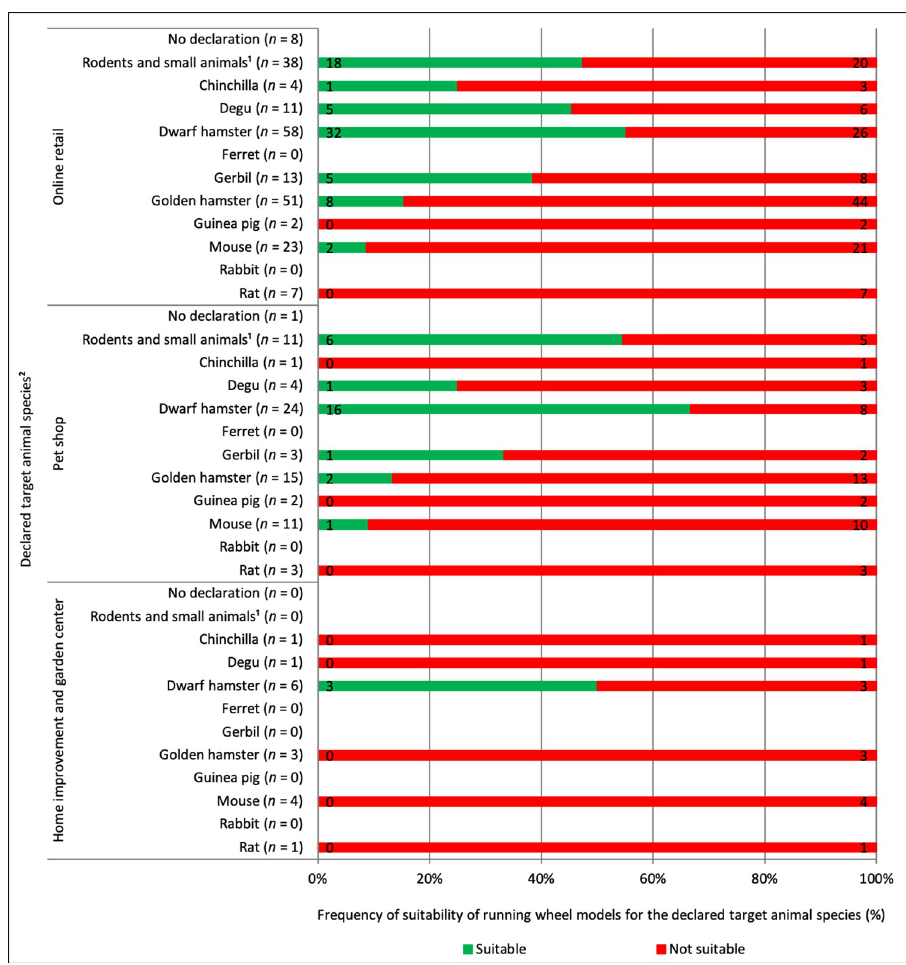
Fig 3. Running wheel models purchasable in German retail (online via internet shops, on site in pet shops or home improvement and garden centers) and declared for a target animal species, as well as their evaluated suitability for the declared target animal species, determined based on running wheel diameter. Basis for the evaluation: online retail = 101 running wheel models, pet shops = 36 running wheel models, home improvement and garden centers = 9 running wheel models. 1 Checked for suitability for dwarf hamsters. 2 Multiple listings